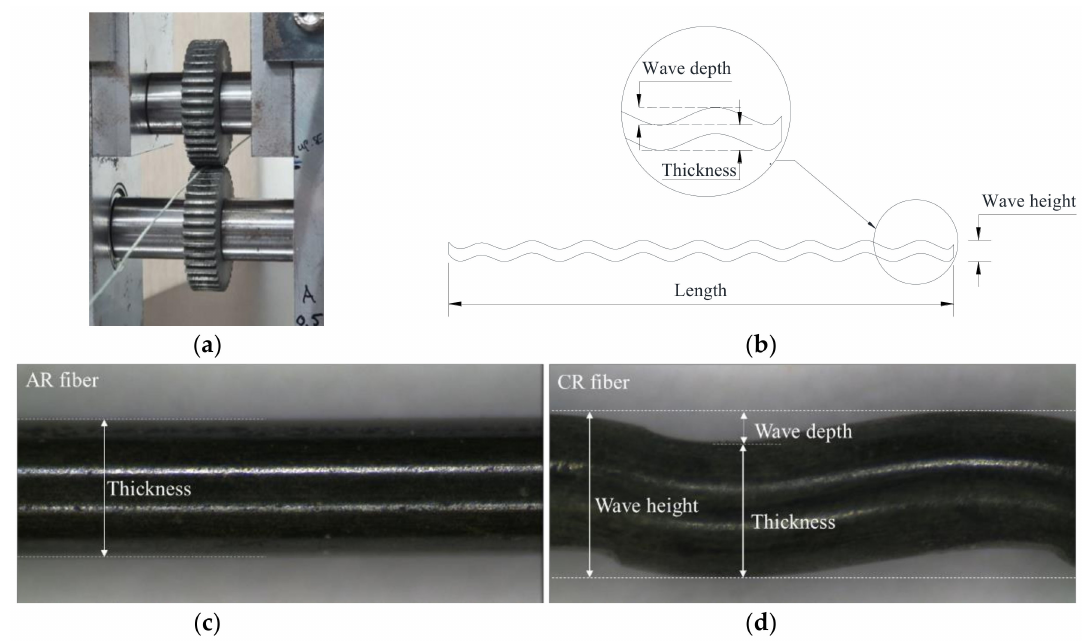
Figure 3. Crimping process and shape of crimped fiber: ( a ) crimping process; ( b ) shape of a crimped fiber; ( c ) photo of AR fiber; and ( d ) photo of CR fiber.